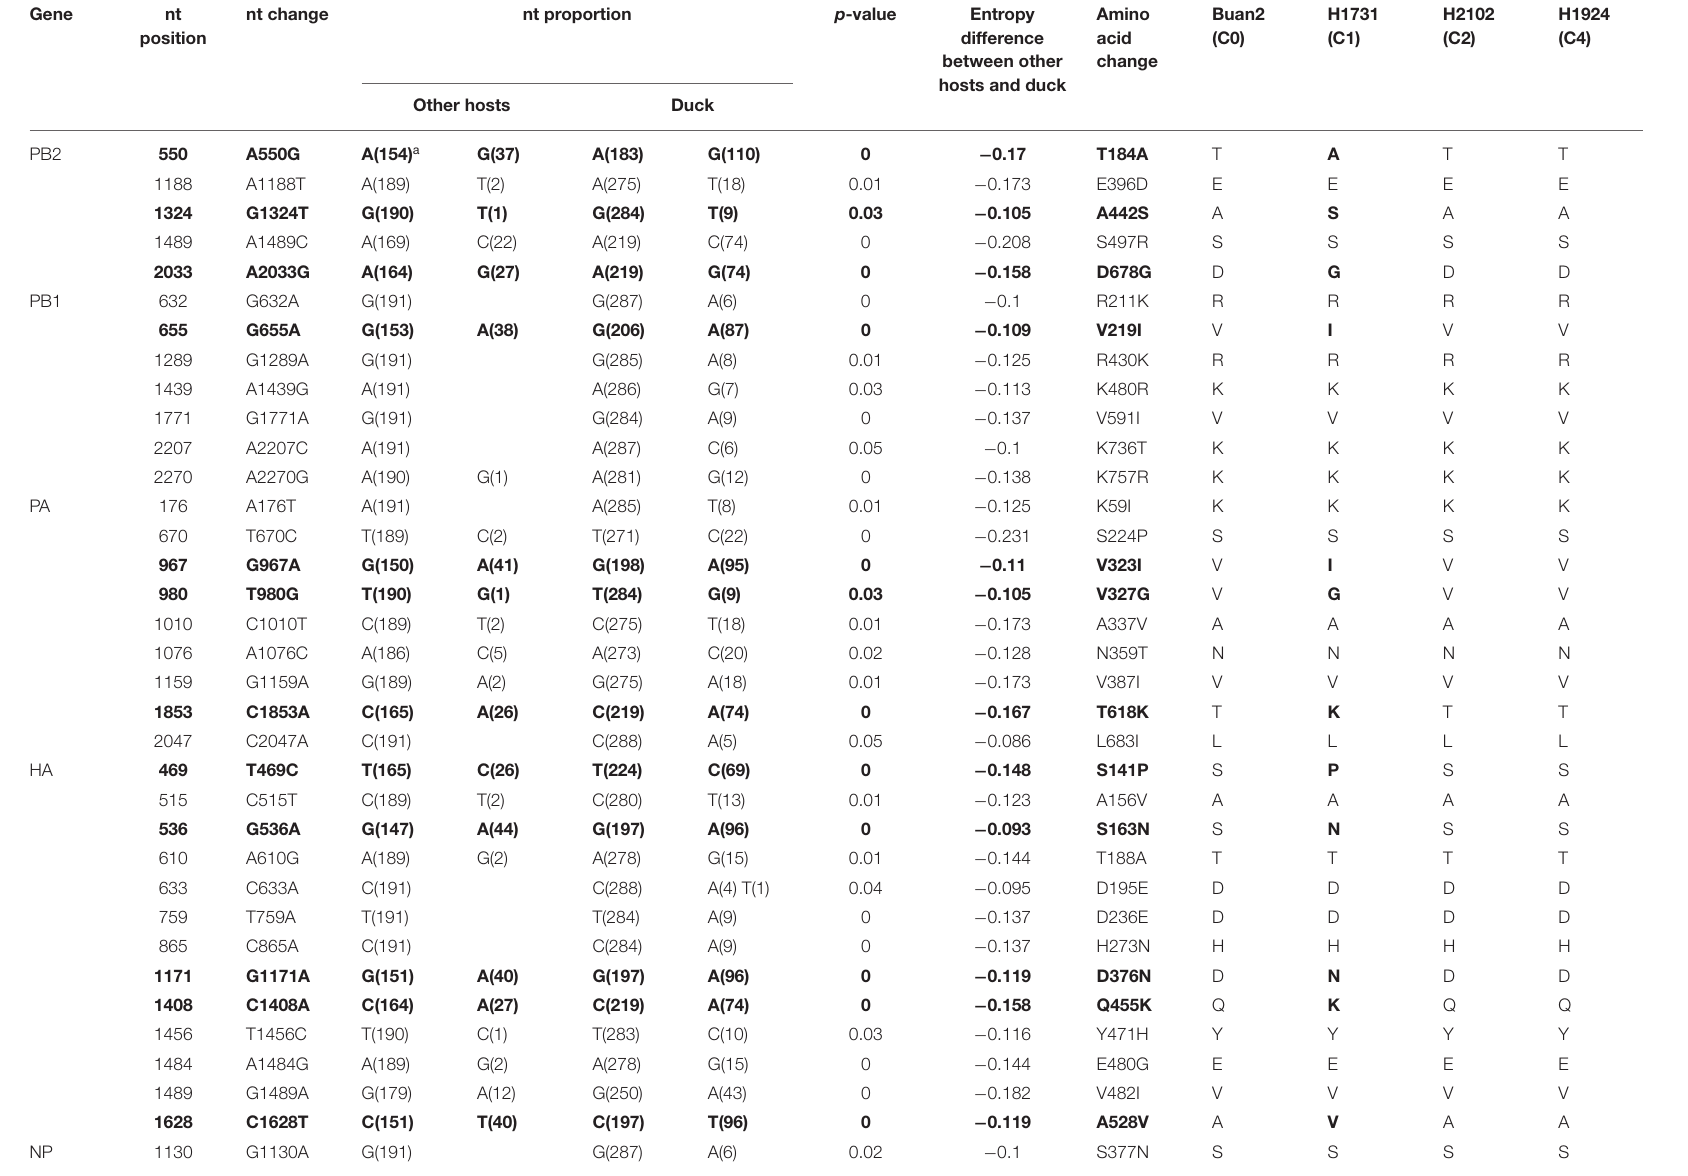
TABLE 2 | Shannon entropy analysis between H5N8 highly pathogenic avian influenza viruses isolated from duck and other hosts. Gene nt nt change nt position